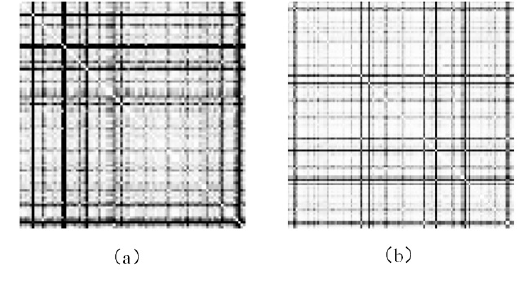
Figure7. The diagram of spatiotemporal similarity matrix Where ( a ) represents the result matrix from Wuchang Railway Station to Wuhan Railway Station while ( b ) represents the matrix from Wuchang Railway Station to Guanggu Square, and the depth of color represents the value of distance. Then, the spatiotemporal spectral clustering method is used to cluster the trajectories, and the clustering results are displayed on ArcMap.